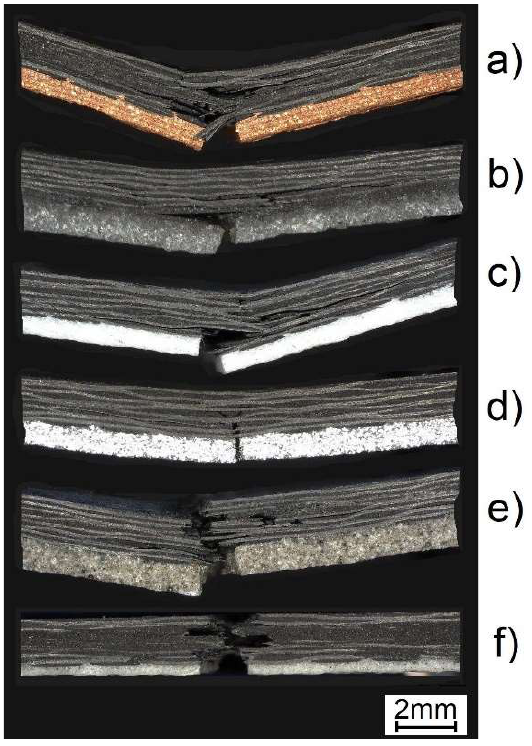
Figure 7. Failure modes of two-layered samples with PLs made of: ( a ) copper; ( b ) quartz sand; ( c ) Al 2 O 3 ; ( d ) aluminum; ( e ) crystalline silica; and ( f ) microballoon powders.